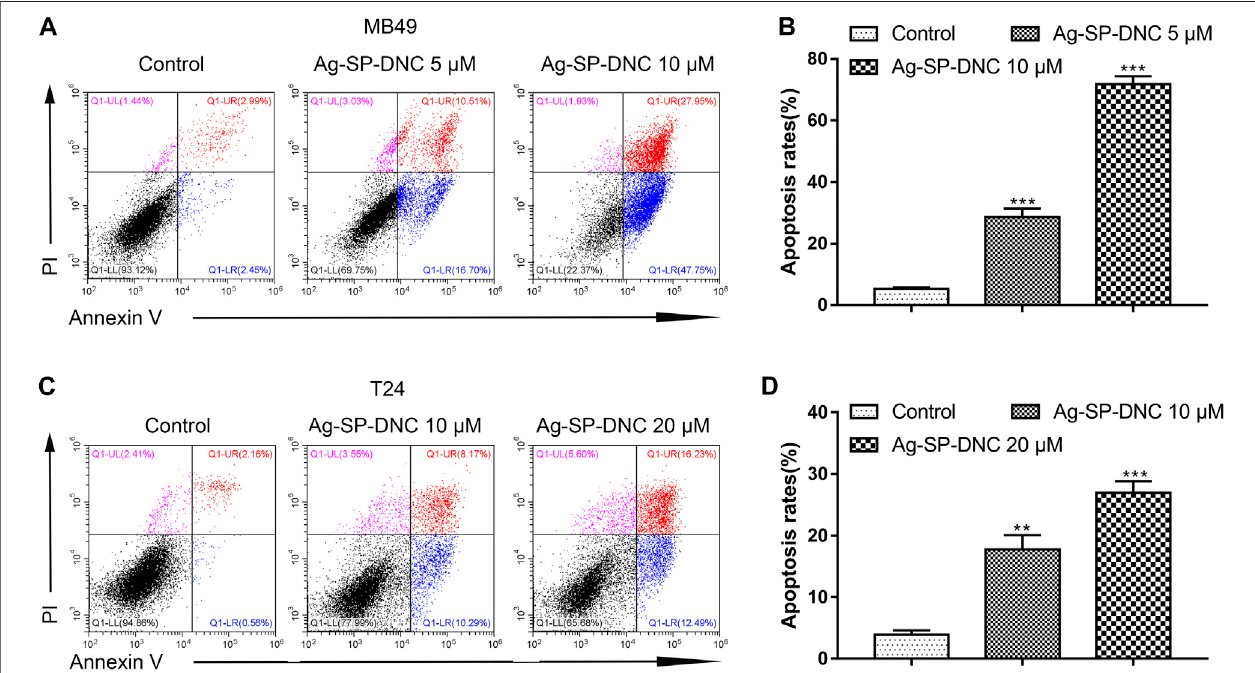
FIGURE4| Ag-SP-DNCinducesbladdercancercellsapoptosis.ThebladdercancercellsweretreatedwithdifferentdoseofAg-SP-DNCfor48 handthenstained with annexin V-FITC/PI followed by fl ow cytometry analysis. (A) The fl uorescence pattern of annexin V-FITC and PI stained MB49 cells. (B) Percentages of annexin V positivecellsfordifferenttreatments.Dataaremean ± SEM;n (cid:1) 3.*** p < 0.001. (C) The fl uorescencepatternofannexinV-FITCandPIstainedT24cells. (D) Percentages of annexin V positive cells for different treatments. Data are mean ± SEM; n (cid:1) 3. ** p < 0.01, *** p <